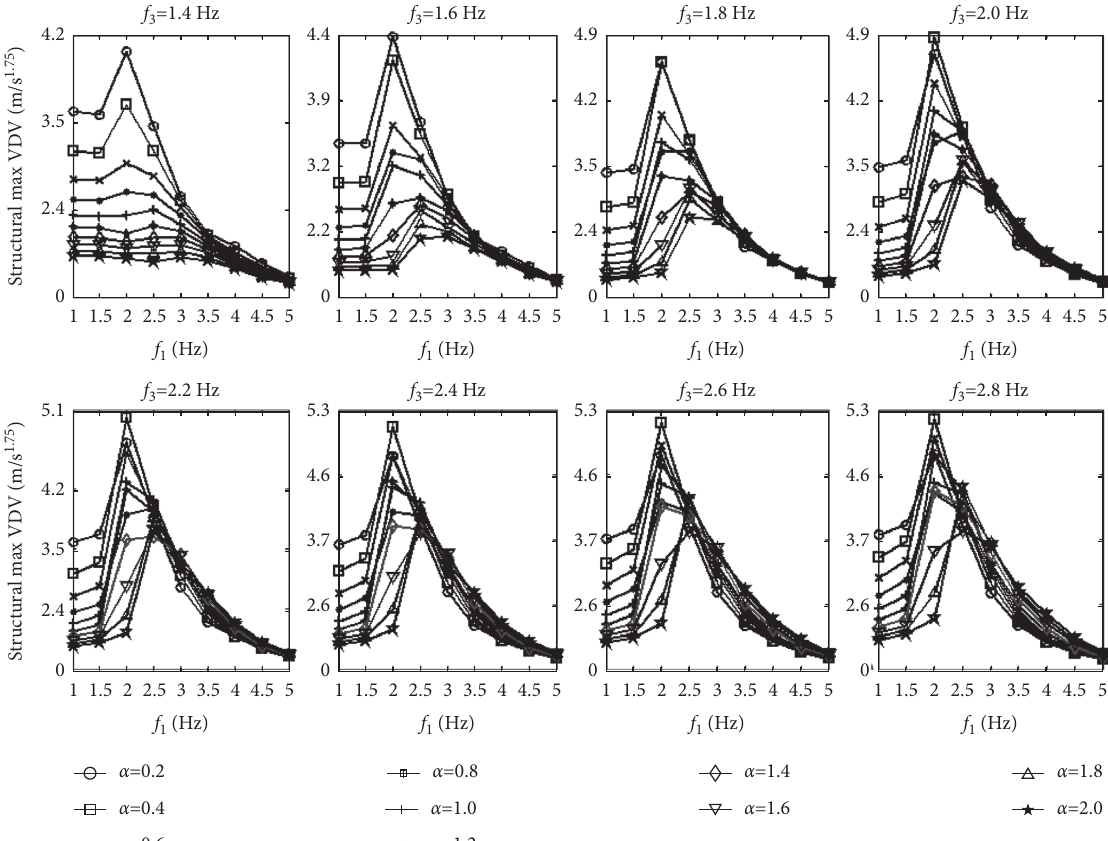
Figure 32: The structural VDV of models with different f